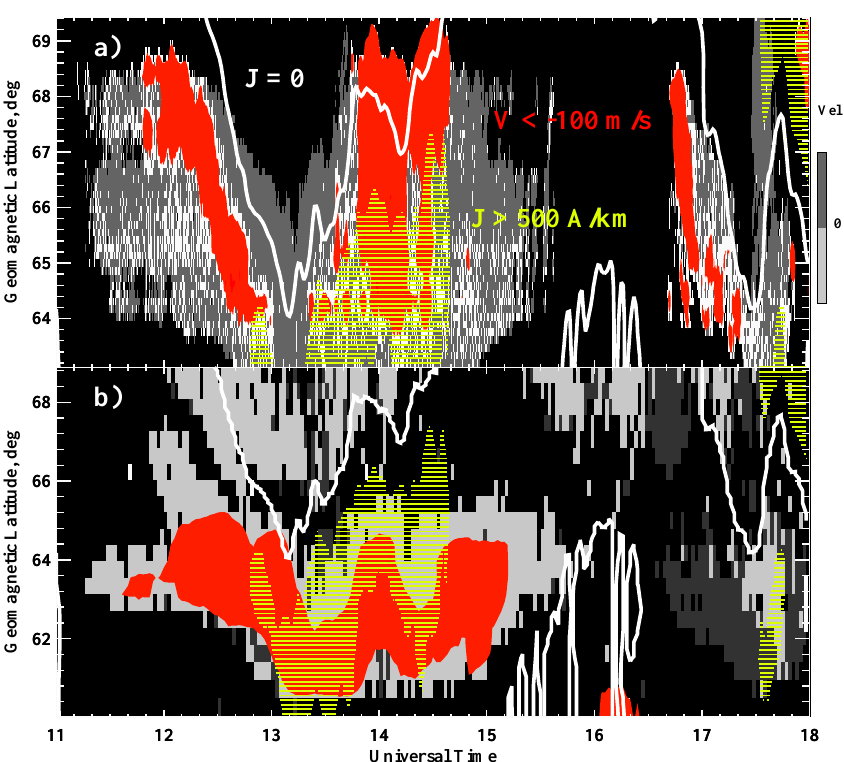
Fig. 7. Comparison between the IMAGE equivalent currents and (a) STARE (beam 8) and (b) CUTLASS (beam 9) velocities. The positive (negative) velocities are shown by the dark (light) grey cells. The white contour is the boundary between eastward and westward electrojets J = 0. The area filled with the red solid color (horizontal yellow lines) corresponds to the ranges with V < − 100m/s ( J> 500A/km).